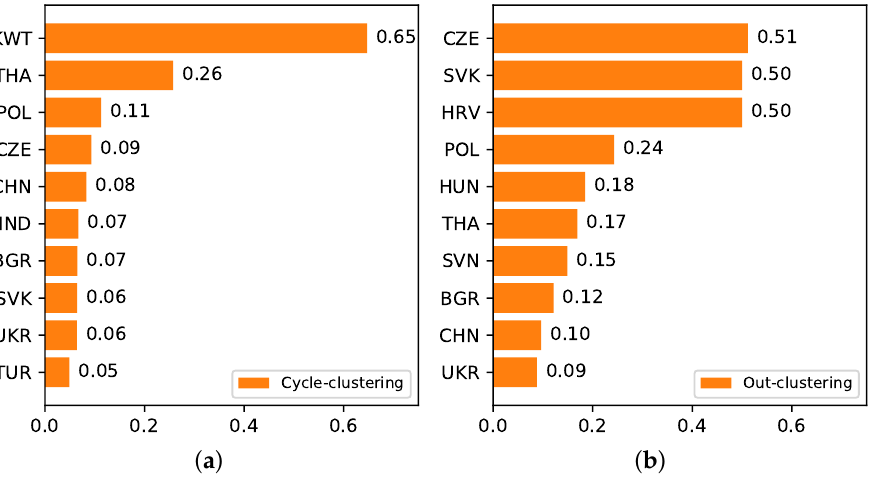
Figure 6. Top 10 countries in the EGSR transmission network in terms of ( a ) out-clustering coefficient and ( b ) cycle-clustering